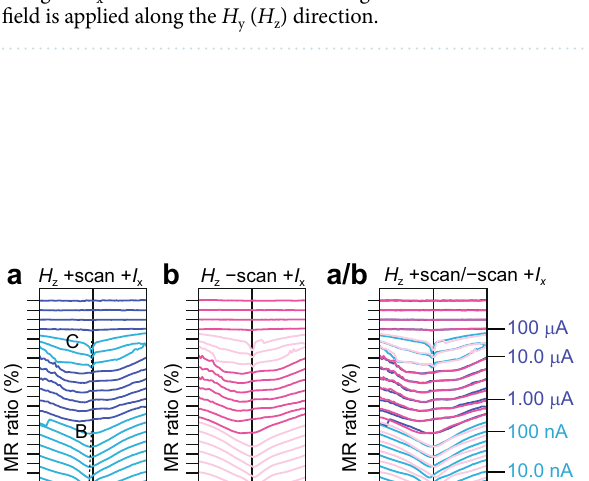
Figure 2. Schematic sample structure examined in our magnetoresistance measurement. Current is applied along the I x direction between the two Ag contacts formed at the surface. The in-plane (out-of-plane) magnetic field is applied along the H y ( H z ) direction.